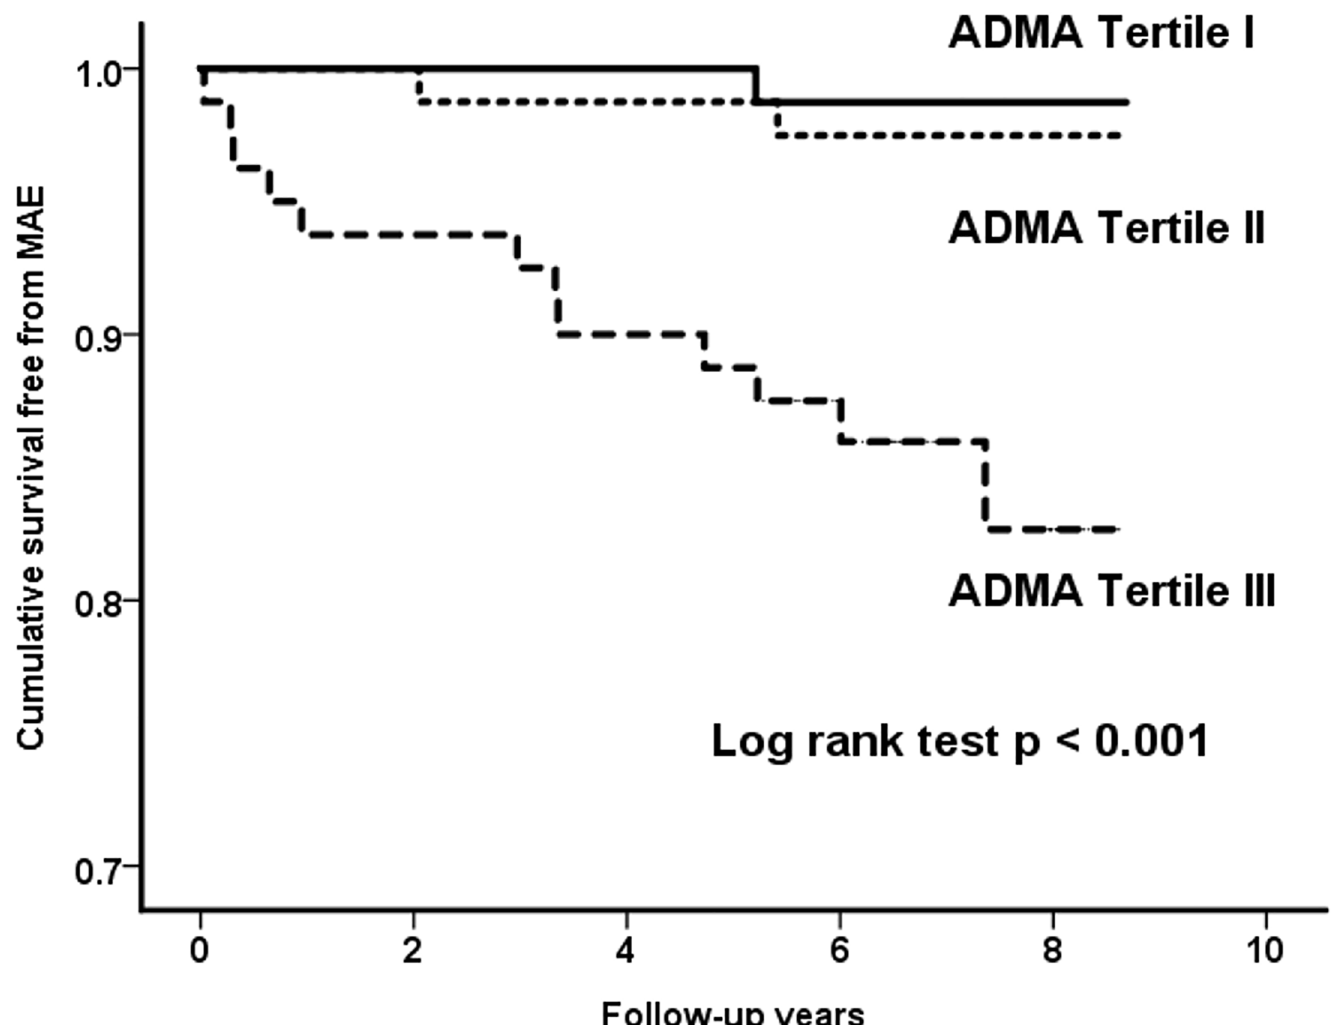
Fig 1. Cumulative survival curves free from major adverseevents. Kaplan-Meier survival analysesduringfollow-upfor major adverseevents, accordingto the plasma ADMA tertiles. P values by log-ranktest are shown.